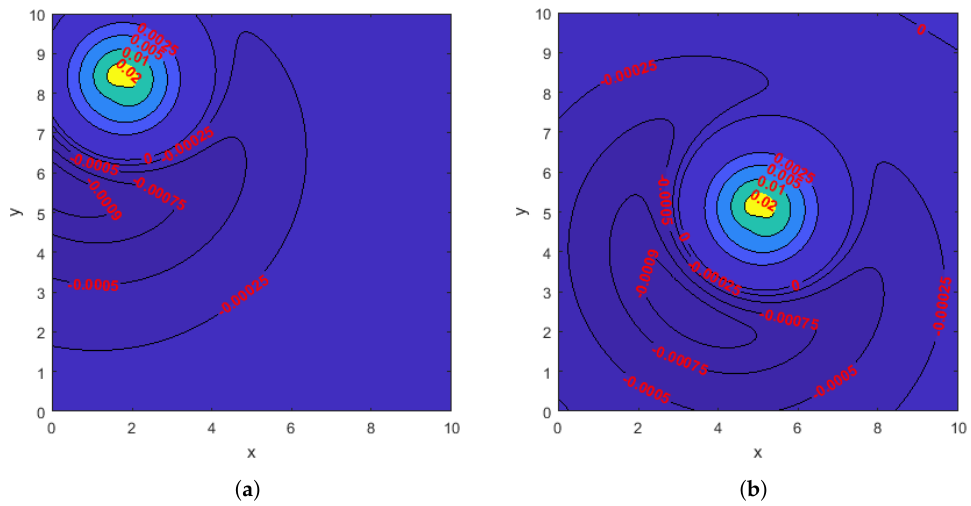
Figure 4. Contour plots of the z -direction velocity on the flow meter (7) with W = 10 at the midpoint of a cycle in the case of a single rotating helix. The phase shift of the helix is 0. ( a ): The location of the helix is shown in Figure 3e. ( b ): The helix is based at ( 5,5 ) , the center of the